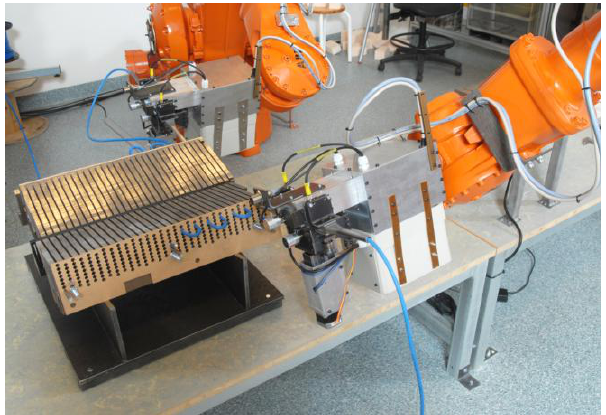
Figure 4. The cable winding experimental robot cell setup. Two ABB IRB4400/60 kg S4C+ M2000 robots, equipped with cable feeder tools, are performing cable winding through a 0.5 m long UU WEC stator section prototype.